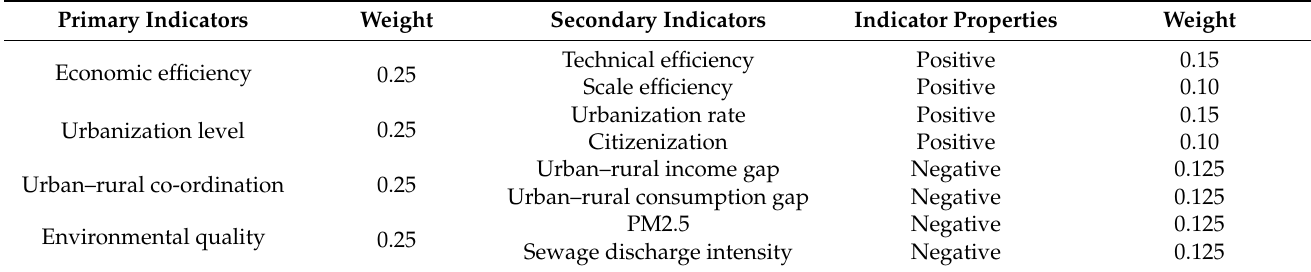
Table 2. Four-dimensional evaluation indicator system and the weights of urbanization quality.